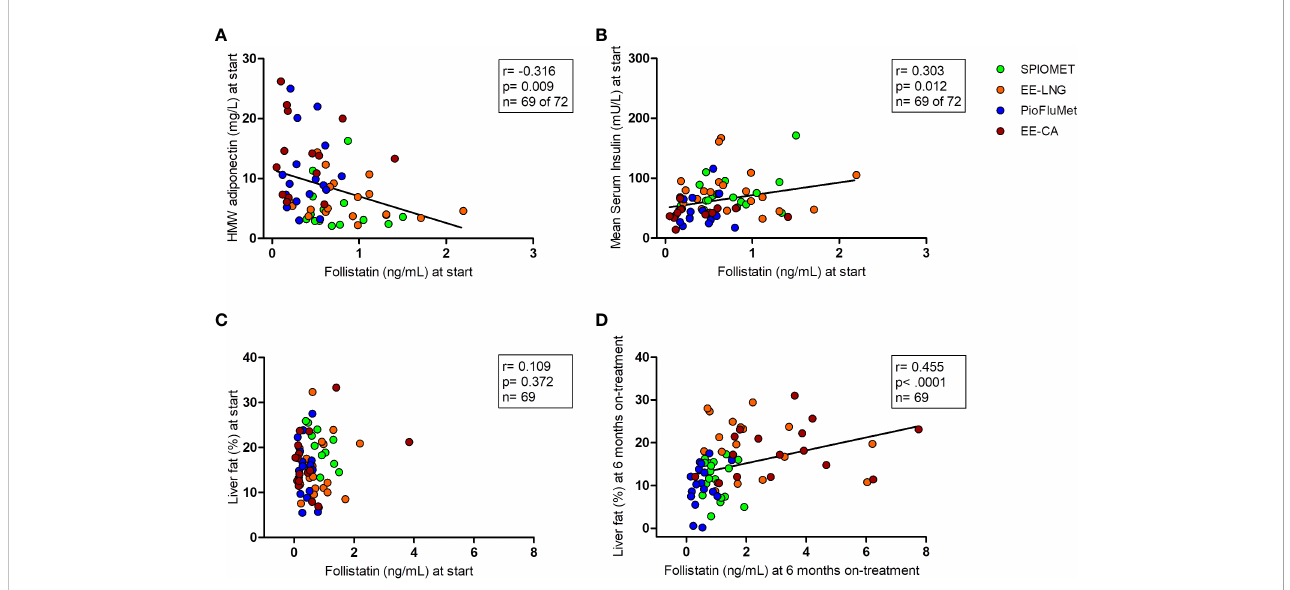
FIGURE 1 Bivariate correlations between circulating follistatin and, respectively, HMW-adiponectin and mean insulin concentration during an oral glucose tolerance test at baseline [panels (A) and (B) ], and liver fat at baseline and after 6 months on treatment [panels (C) and (D) ], in adolescent girls with PCOS (N=69), randomized to receive PioFluMet, SPIOMET, EE-CA or